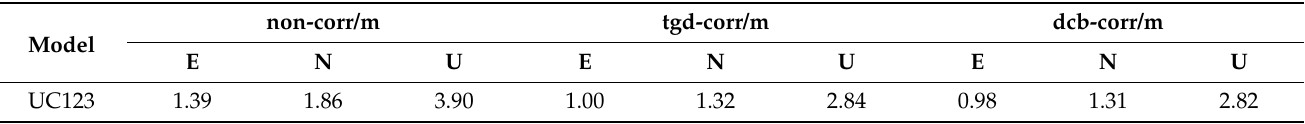
Table 4. Average positioning accuracy of SPP for UC123 model